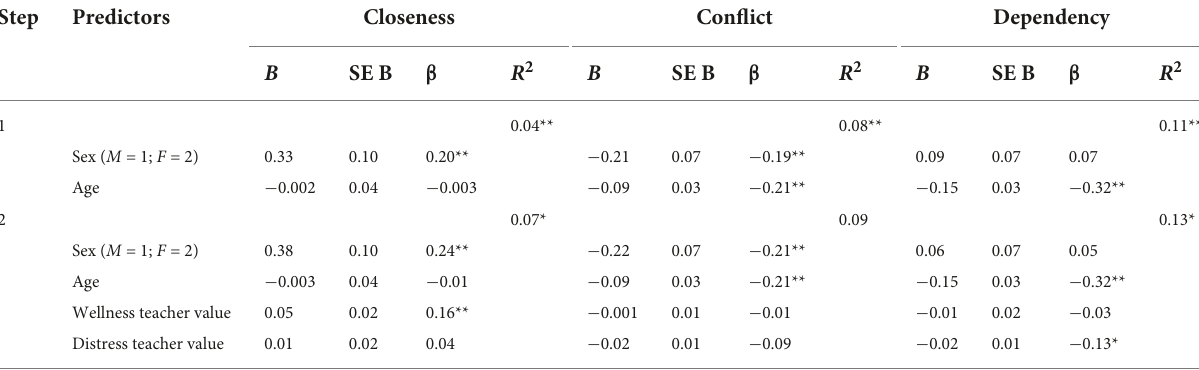
TABLE 2 Summary of hierarchical regressions predicting student–teacher relationship from drawing